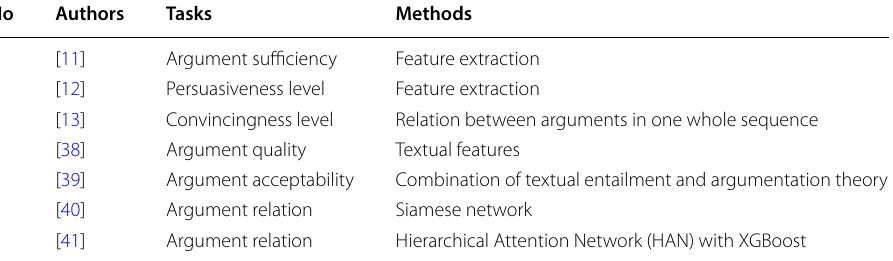
Table 2 Current works in argument